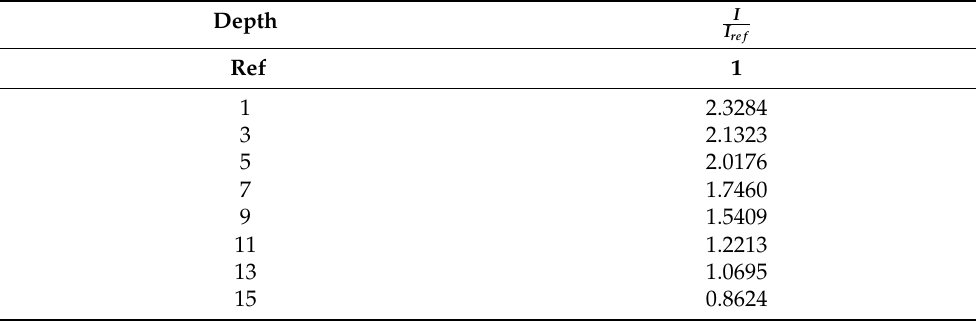
Table 1. Depth sweep with terminal current